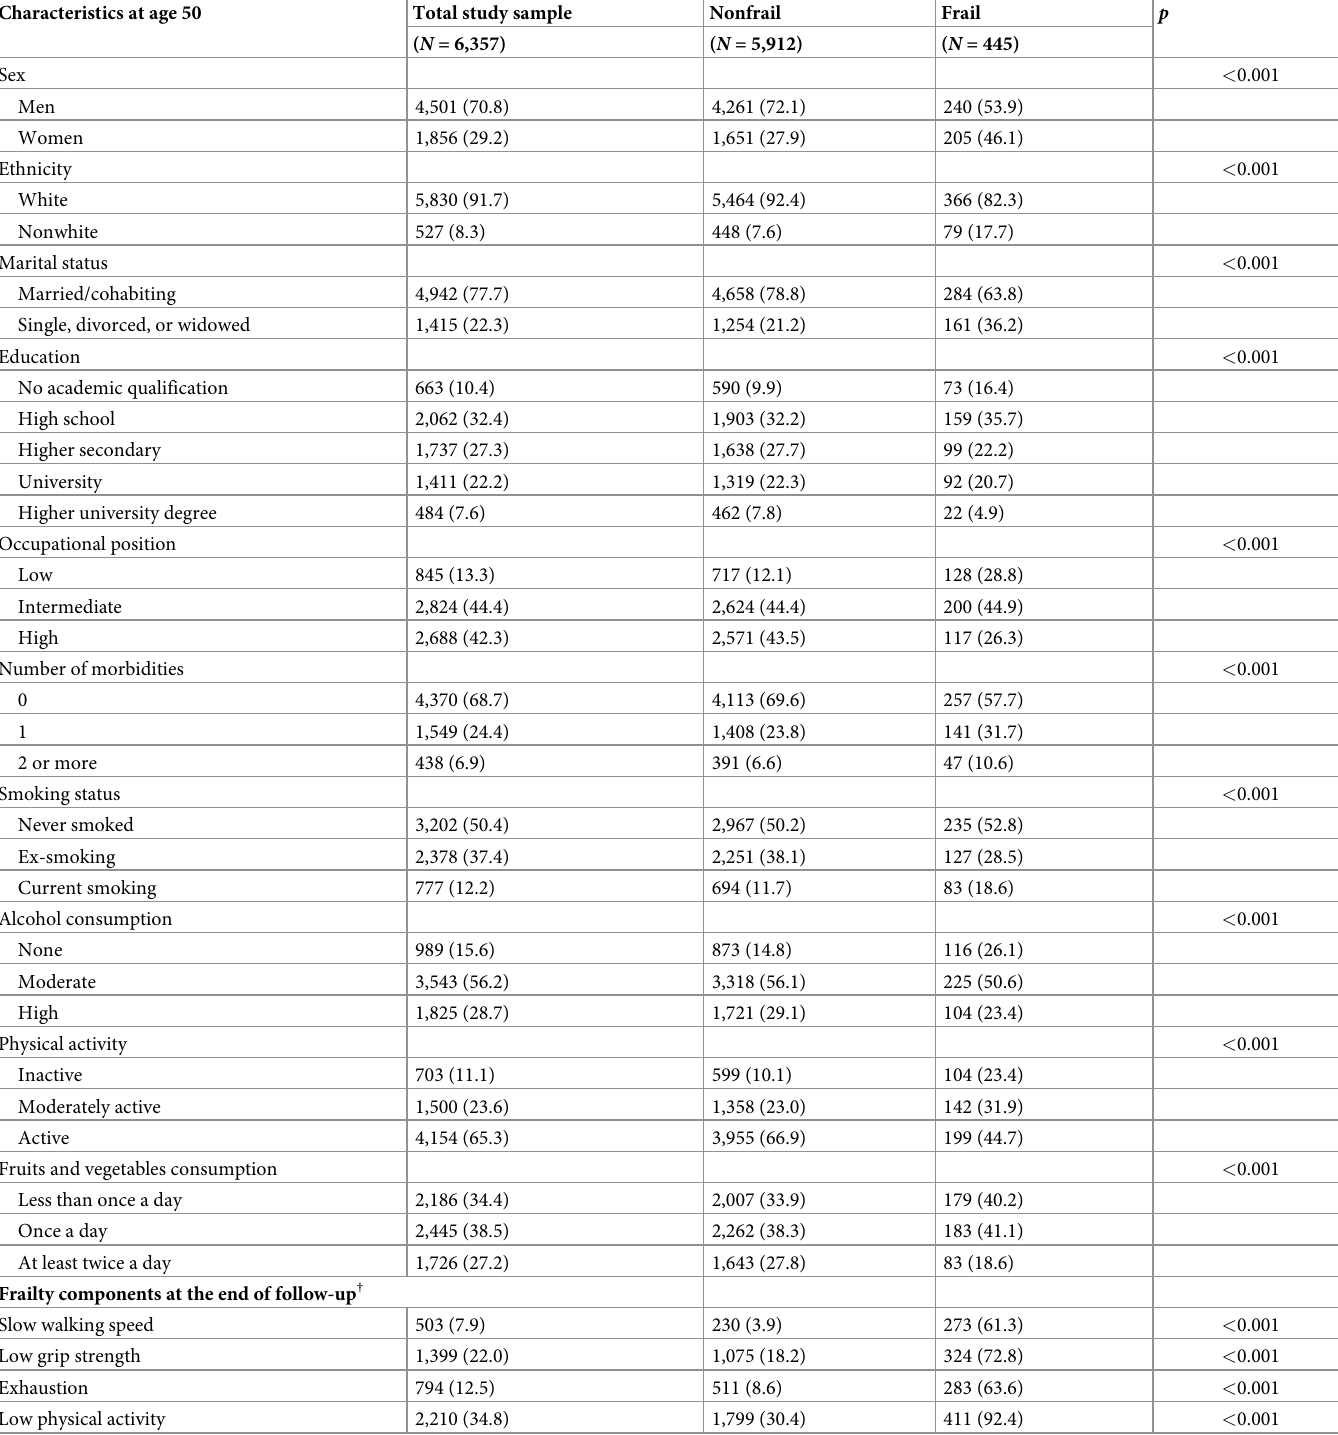
Table 1. Characteristics of the study sample according to frailty status at the end of follow-up � . Characteristics at age